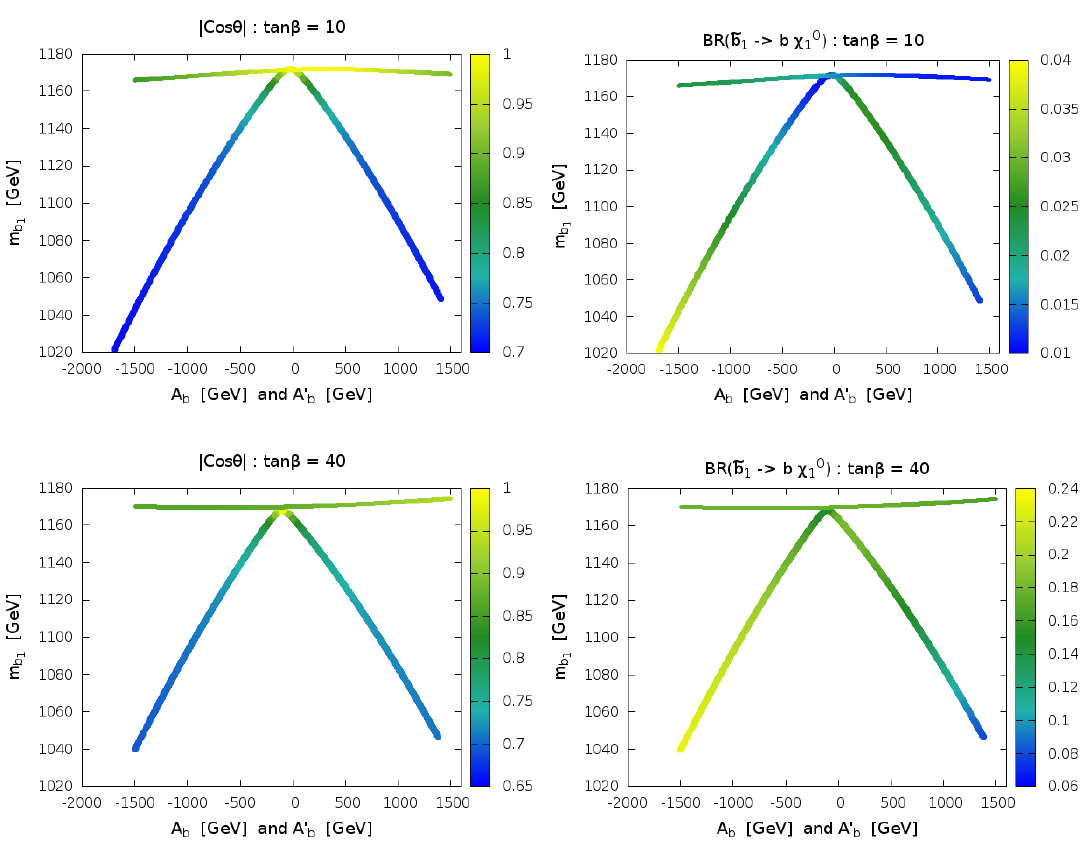
Figure 7 . Variations of cos (cid:18) ~ in the top (bottom) panel for a scenario with both the LSP neutralino and the lighter chargino being higgsino-like. The (cid:12)xed parameters used are as follows: (cid:22) = 200 GeV, M 1 = 500 GeV, M 2 = 1 : 1 TeV, A b = 0, (cid:22) 0 = 0, m Flatter lines represent the corresponding variations as functions of A b in the